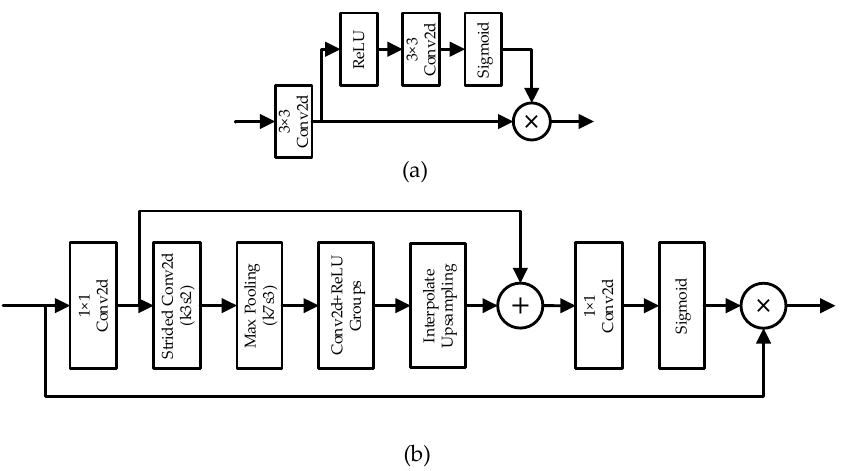
Figure 2. The detailed structure of spatial attention mechanism. ( a ) SU in SelNet, ( b ) EFA block in RFANet.